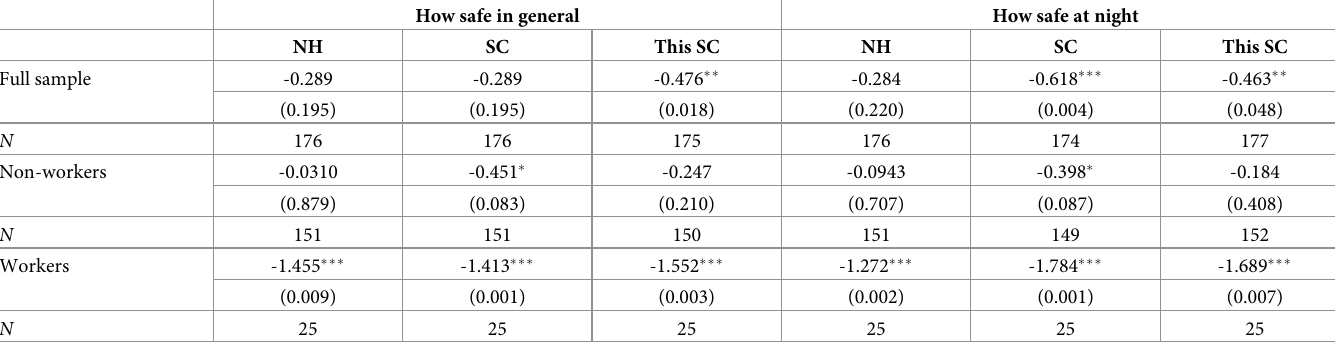
Table 6. Estimates of the effect of interacting with the intervention on fear of